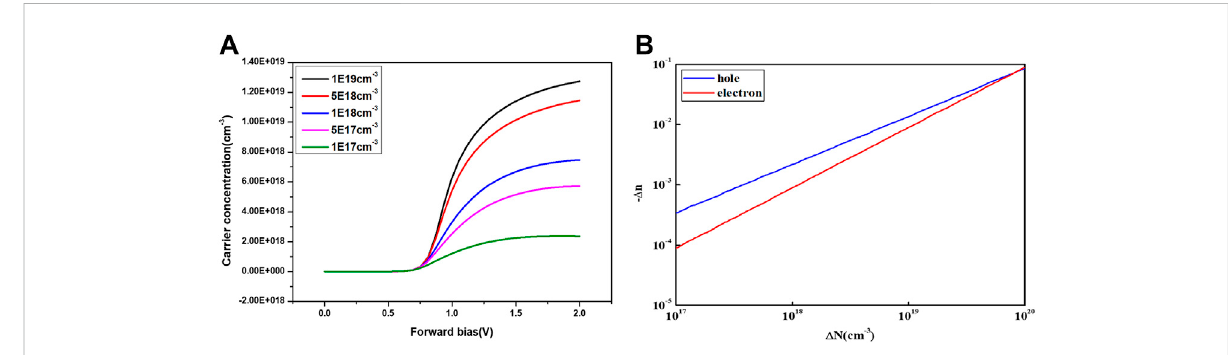
FIGURE 6 (A) Relationship between doping concentration and carrier injection concentration. (B) Variation curve of carrier concentration and Δ n